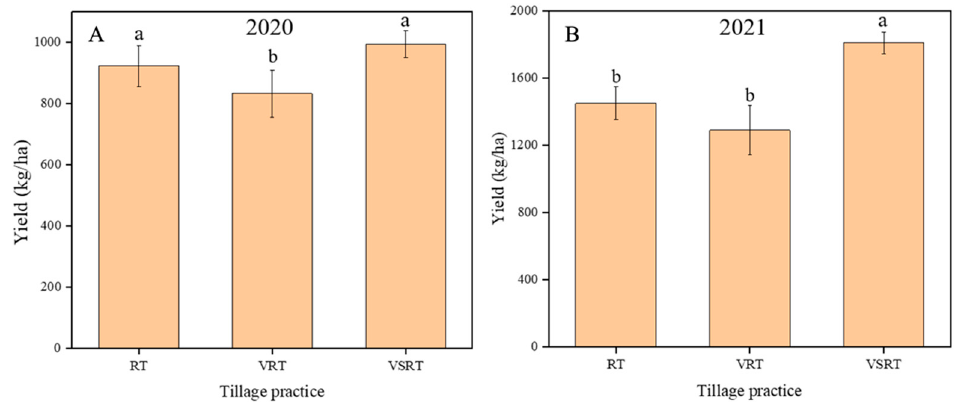
Figure 8. Broccoli yield under the three tillage practices. ( A ): The broccoli yield in 2020; ( B ): The broccoli yield in 2021. Different lowercase letters in the same soil layer indicate significant differences at a p < 0.05 level. Rotary tillage, RT; vertical rotary tillage, VRT; vertical smashing rotary tillage, VSRT.